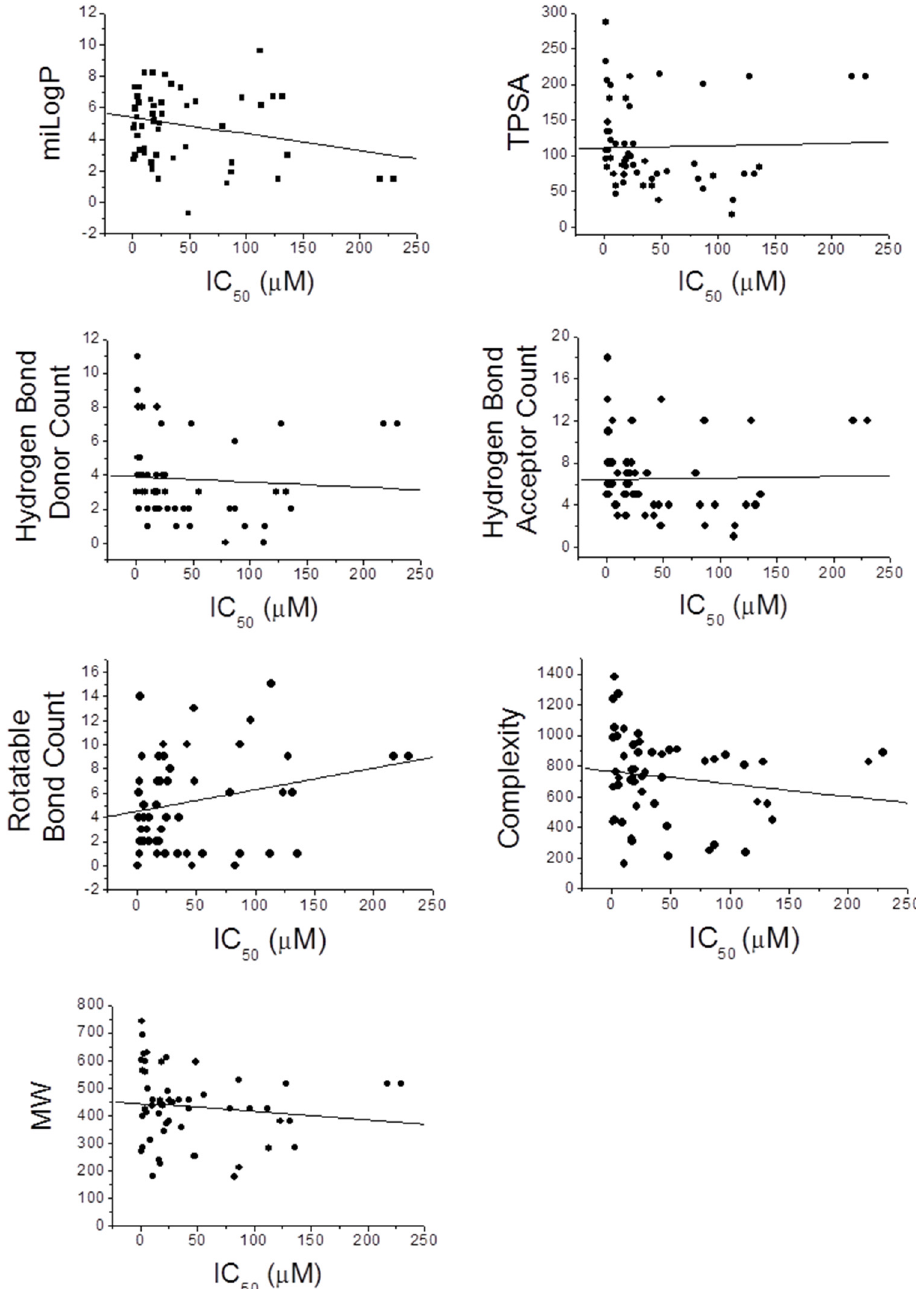
Figure 7. Relationship between the chemical-physical properties and the IC 50 values for α -glucosidase of the best sixty compounds. Chemical-physical data were recovered from PubChem database and analyzed using OriginPro 2021 Software.